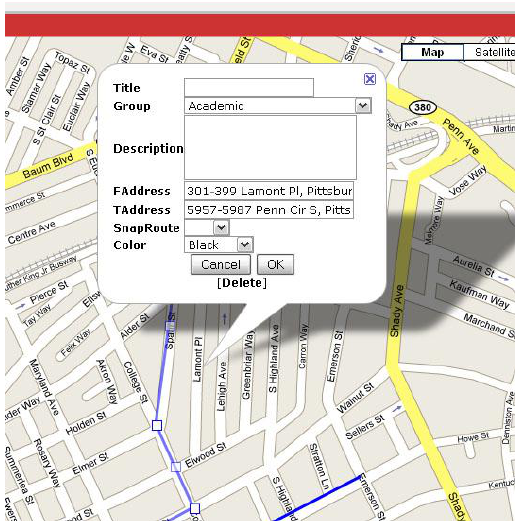
Figure 2 . Example POI selection and annotation in SoNavNet.